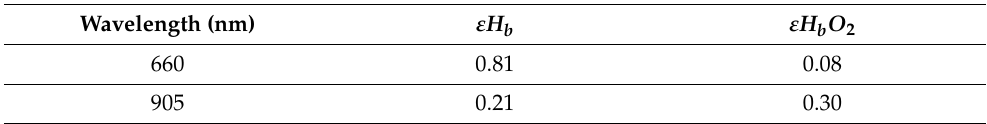
Table 1. The extinction coefficients (Lmmol − 1 cm − 1 ) of the reduced ( ε H b ) and ( ε H b O 2 ) oxygenated hemoglobin at the wavelengths of 660 nm and 905 nm.